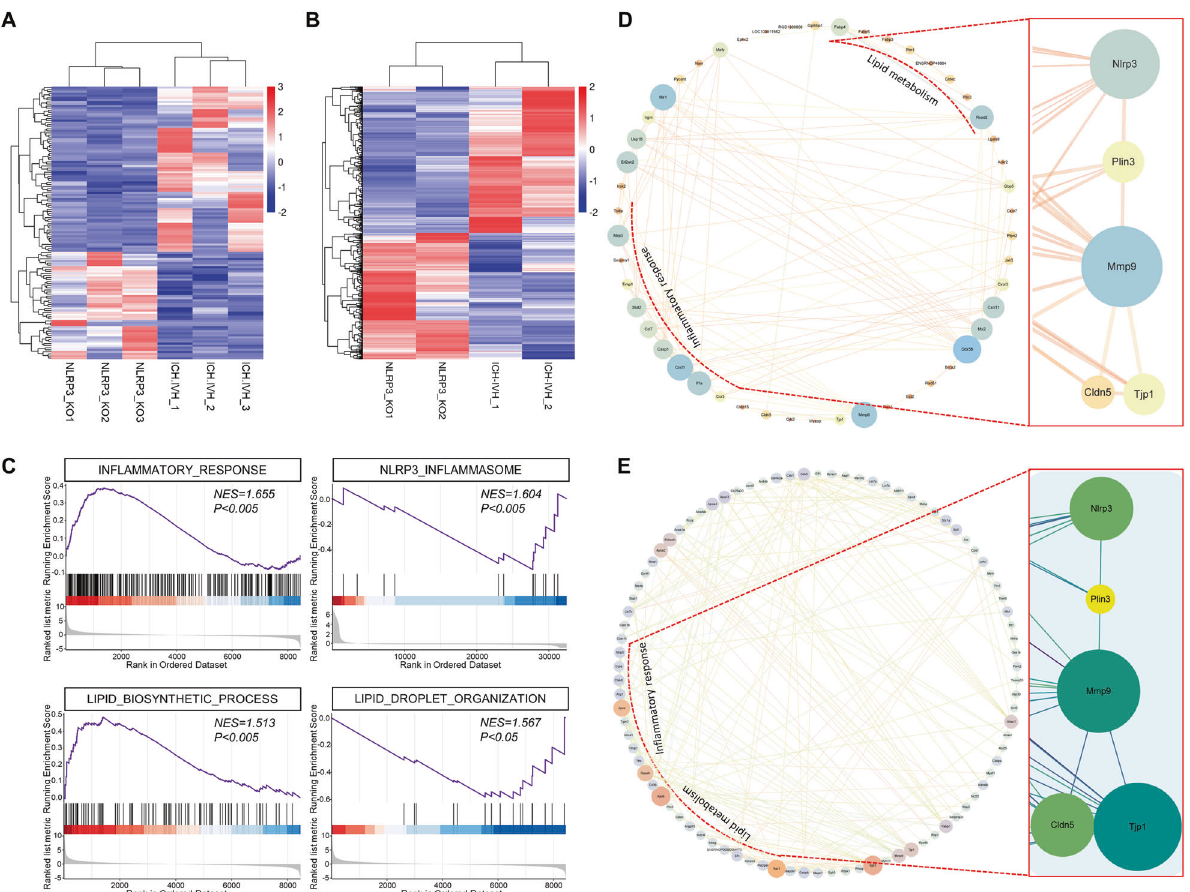
Fig. 4 Bioinformatic analysis revealed an in fl ammatory response and lipid metabolism changes in Nlrp3 − / − rats 3 days after ICH-IVH. A Heatmap of differentially expressed genes from transcriptome sequencing of Nlrp3 − / − rats versus WT rats. B Heatmap of differentially expressed proteins from proteome sequencing. C GSEA of sequencing results showing a diminished in fl ammatory response and altered lipid metabolism in Nlrp3 − / − rats. D Network images showing in fl ammatory, lipid-related, and potentially related genes after ICH-IVH with or without NLRP3 knockout. E Protein – protein interaction network of in fl ammatory and lipid-related the disruption of the B-CSFB after ICH-IVH, which may be one of the important injury targets for the development of PHH. Quantitative transcriptomic and proteomic analysis of the choroid plexus revealed functional changes in lipid metabolism that reduced the abundance of LDs in Nlrp3 − / − rats To investigate the potential mechanism by which NLRP3 knockout could improve PHH by affecting B-CSFB function, we performed transcriptome and proteome sequencing analysis of choroid plexus tissues from WT and Nlrp3 − / − rats 3 days after ICH-IVH. The results of both transcriptome and proteome sequencing showed that the expression of several genes and proteins was upregulated or downregulated between the two groups (transcriptome: fold change ≥ 2 as the threshold of change, P ≤ 0.05 as the differentially expressed gene screening criterion; proteome: fold change ≥ 1.2 as the threshold of change, P ≤ 0.05 as the differentially abundant protein screening criterion). Overall, 111 genes were upregulated and 149 genes were downregulated in the transcriptome (Fig. 4a), while 516 proteins were upregulated and 445 proteins were downregulated in the proteome (ICH-IVH(WT) versus ICH-IVH(Nlrp3 − / − )) (Fig. 4b). Heatmaps based on differentially expressed genes or proteins were used to visualize these results clearly. Furthermore, we analyzed the functions of these differentially expressed genes and proteins by GSEA and found that lipid metabolism functions were altered after NLRP3 knockout. Speci fi cally, LD formation was dysfunctional. PLIN3